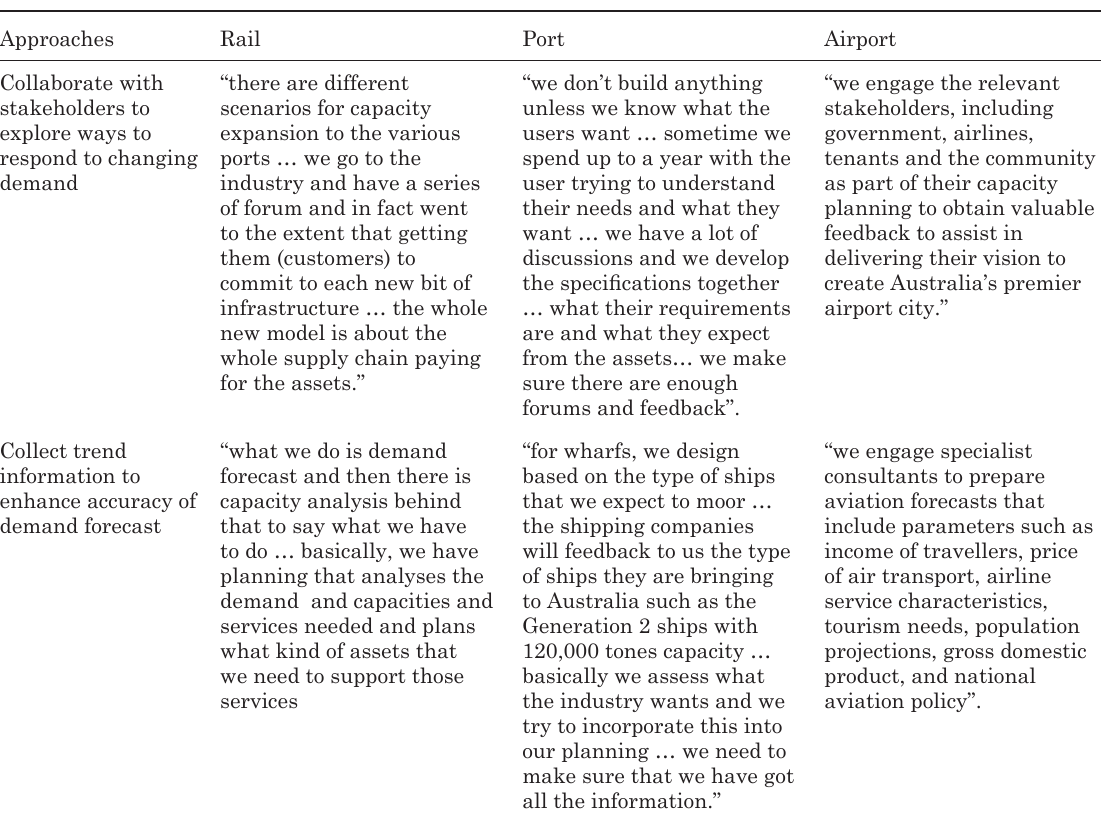
table 4. Summary of approaches adopted for the capacity management process